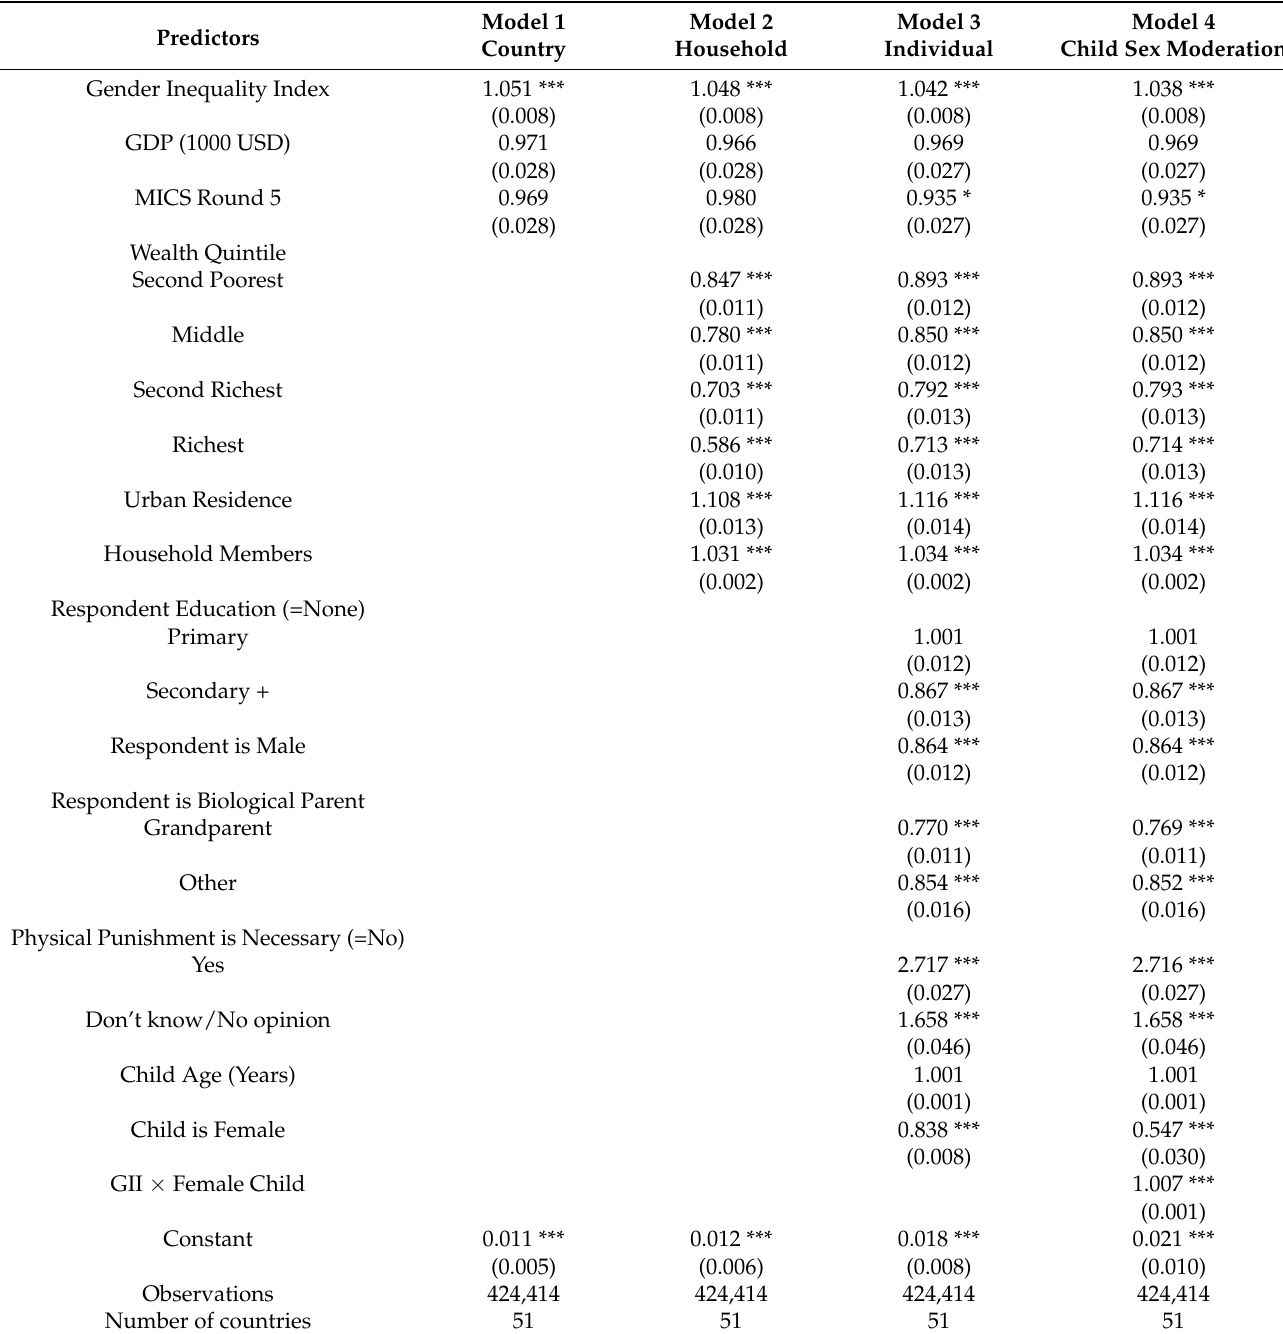
Table 2. Multilevel Logistic Regression Models Predicting Physical